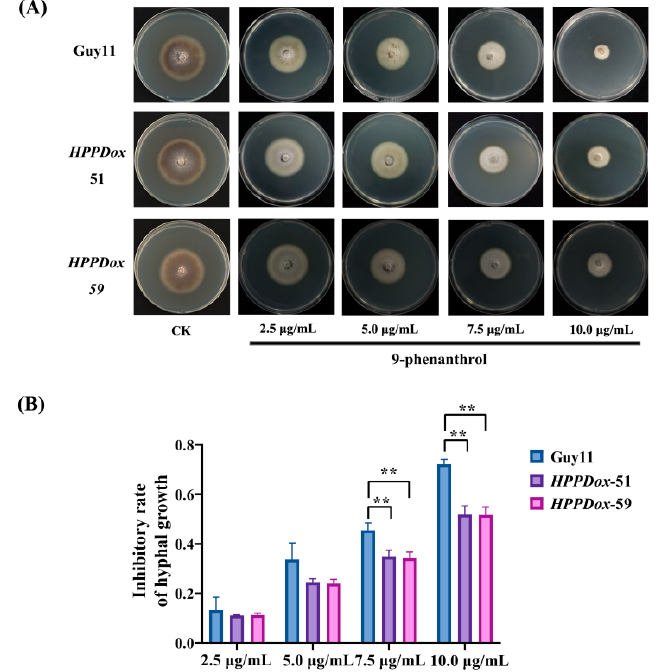
Figure 4. Overexpression of 4-hydroxyphenylpyruvate dioxygenase (HPPD) enhances the tolerance of 9-phenanthrol in M. oryzae . ( A ) The colony appearance of HPPD overexpression strains and WT under 9-phenanthrol treatment. ( B ) The inhibitory rates of hyphal growth of M. oryzae under 9-phenanthrol treatment. Values are presented as the mean of results of triplicate experiments ± SD. The significant differences between treatments were calculated by Student t -test, ** p < 0.01.